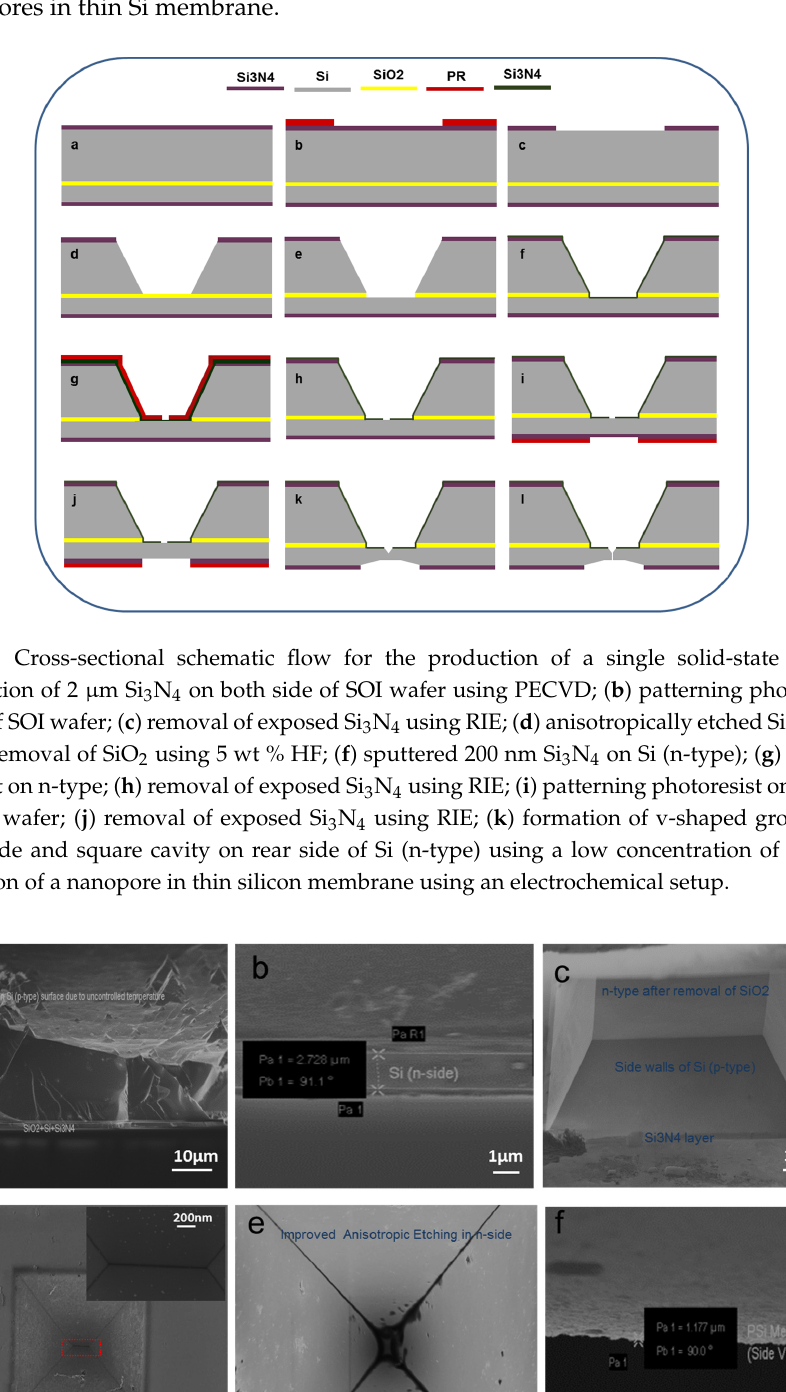
Figure 2. Formation of square and v ‐ shaped groove cavities in silicon. ( a ) Small pyramids produced in the square cavity of Si (p ‐ side) due to uncontrolled KOH concentration and temperature; ( b ) smooth favorable surface Si (p ‐ side) with controlled KOH concentration and temperature; ( c ) Si (n ‐ side) after removal of SiO 2 ; ( d ) uneven pyramid with long v ‐ shaped groove in Si (n ‐ side); ( e ) controlled v ‐ shaped small pyramid in Si (front side of n ‐ type); and ( f ) thin Si membrane with thickness of 1.17 μ m. ( a , b , f ) Cross sectional view; ( c – e ) Top view.